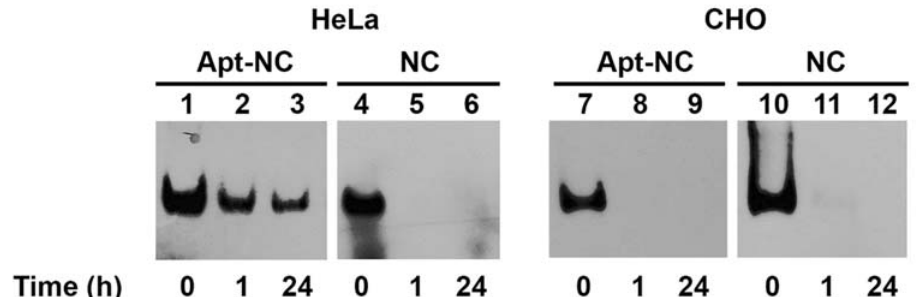
Figure 2. DNA blot of Apt-NC (lanes 2–3 and 8–9) and non-functionalized NC (lanes 5–6 and 11–12) purified from HeLa and CHO cell extracts after 1 and 24 h incubation. In lanes 1, 4, 7, and 10, 30 ng of nanocages before incubation with cells (time 0) are shown. Biotinylated nanostructures were detected with the streptavidin (HRP)–biotin reaction.